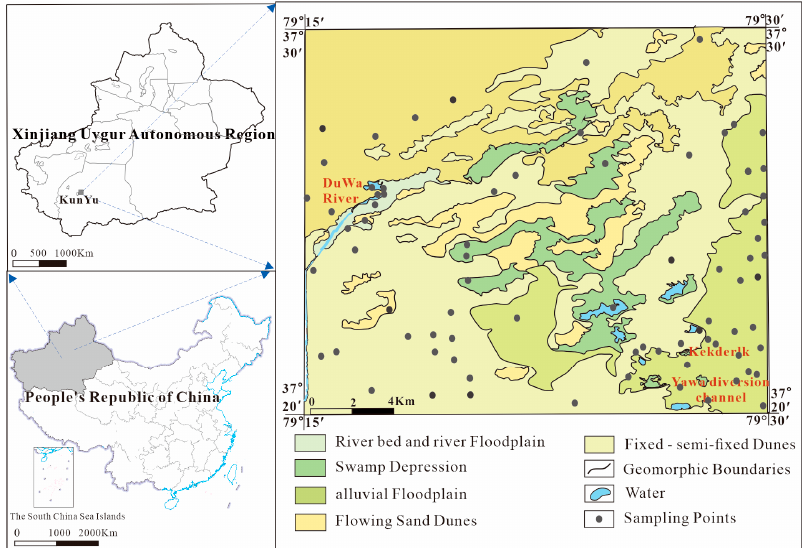
Figure 1. Geomorphology type and location of sampling sites in the study area.